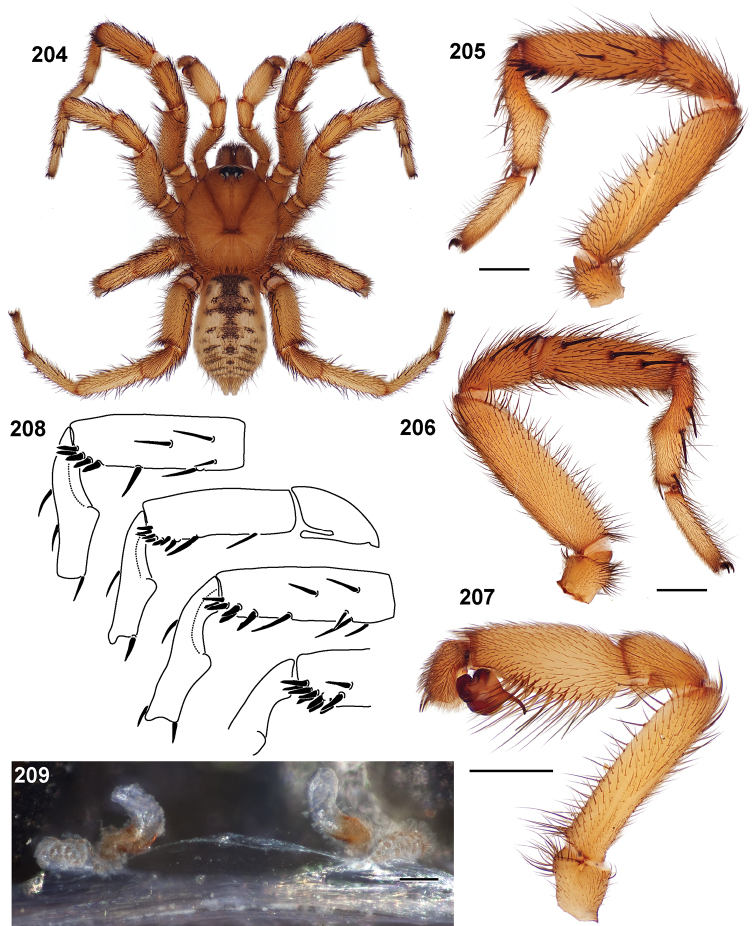
Aptostichus cahuilla sp. n. 204–207 male holotype from Riverside County, Winchester (AP392); scale bars = 1.0mm 204 habitus [805952] 205 retrolateral aspect, leg I [805944] 206 prolateral aspect, leg I [805948] 207 retrolateral aspect, pedipalp [805950] 208 line drawings of male leg I tibia and metatarsus spination pattern variation 209 cleared spermathecae, female paratype (AP221) [806626]; scale bar = 0.1mm.